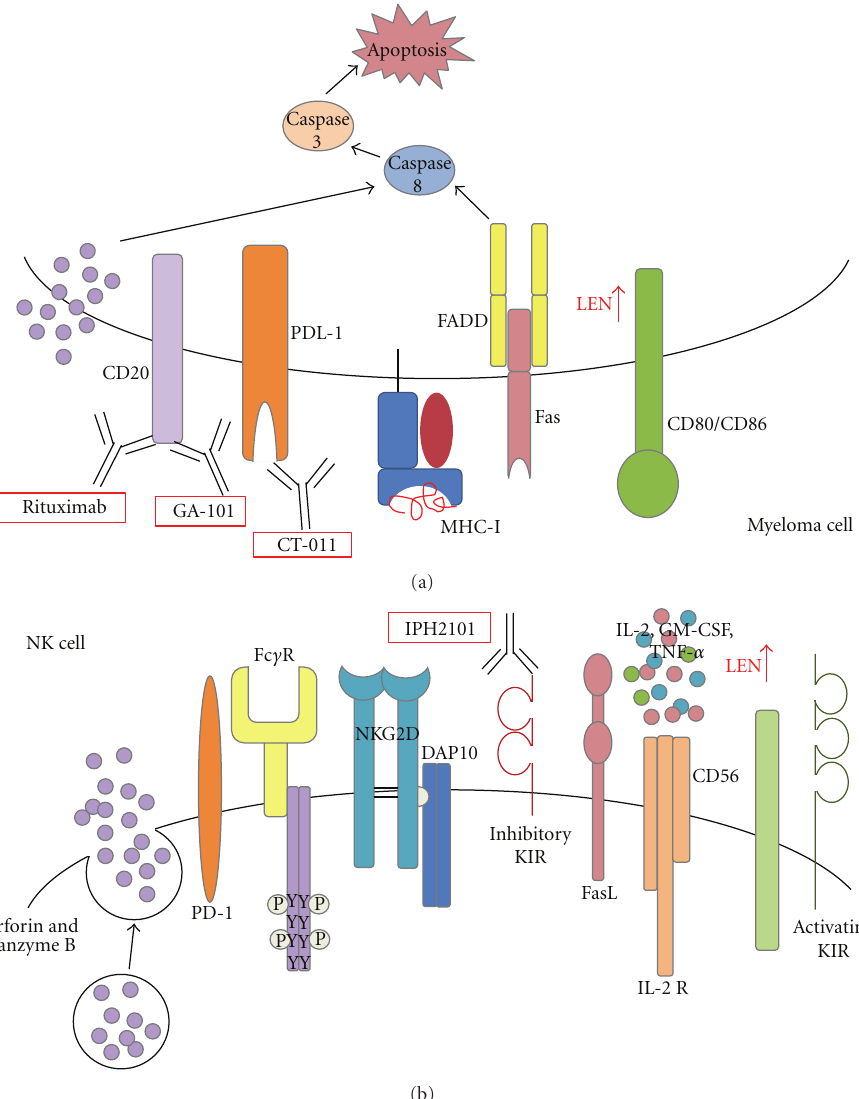
Figure 3: Lenalidomide alone, or in combination with a variety of therapeutic monoclonal antibodies, increases NK-cell-mediated killing of multiple myeloma cells. Lenalidomide (LEN) increases IL-2 secretion from by-standing T helper cells which augments NK cell activity. Lenalidomide, as described previously, upregulates Fas expression and costimulatory molecules on MM cells leading to greater Fas-mediated apoptosis. Lenalidomide has also been shown to augment the ADCC e ff ect of various monoclonal antibodies like Rituximab (anti-CD20), GA-101 (glycoengineered anti-CD20), and CT-011 (anti-PDL-1). CT-011 blocks PD-1 ligand on the MM cells, interfering with binding to PD-1 and inhibiting NK cell activity. Binding of the anti-CD20 antibodies to their targets on MM cells increases complement-dependent cytotoxicity (CDC), as well as NK-cell recognition and killing of the MM cells. IPH2101 is an anti-inhibitory KIR that has been shown in combination with lenalidomide to increase NK-cell killing as well, as blocking the inhibitory signals allows for NK activation and detection of the tumor